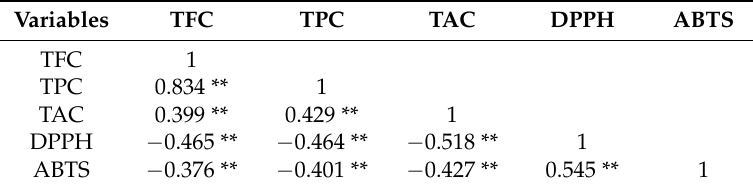
Table 4. Pearson’s correlation coefficients between the